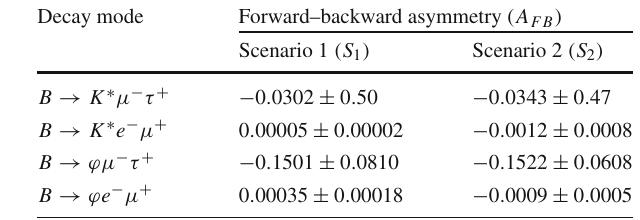
Table 4 Predicted values of forward–backward asymmetries for LFV B → K ∗ and B s → ϕ decays in 1 st and 2 nd scenarios